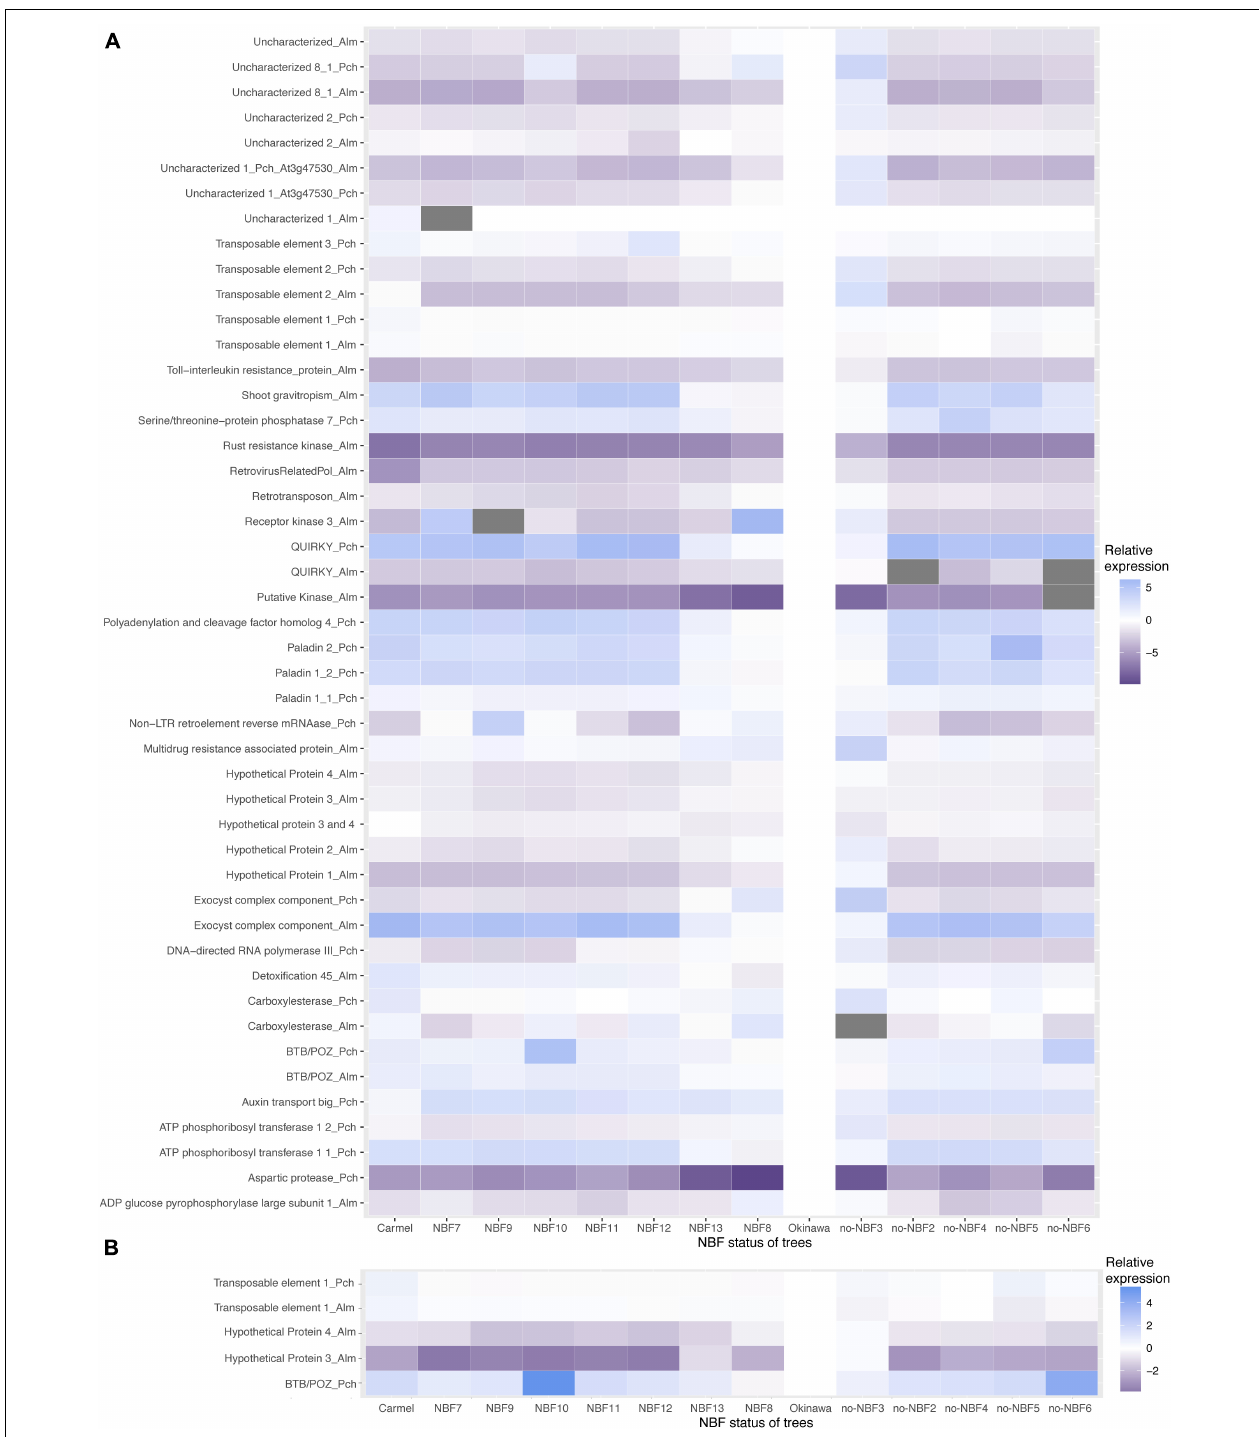
FIGURE 3 | Heatmaps displaying normalized Cq values of DMR-associated genes for NBF and no-NBF trees. Samples were normalized to ‘Okinawa’ which was set to zero and displayed in white color. The scale shows increasing (cid:49)(cid:49) Cq values and lower relative gene expression with the color blue, and with lower (cid:49)(cid:49) Cq values and higher relative gene expression in purple. An underscore is used in the names to show whether the gene was from almond (_Alm) or peach (_Pch) alignments. (A) Displays all DMR-associated genes run at both 55 and 53 ◦ C annealing temperatures in the qPCR experiment. (B) Displays the top five predicted DMR-associated genes and their corresponding (cid:49)(cid:49) Cq values.